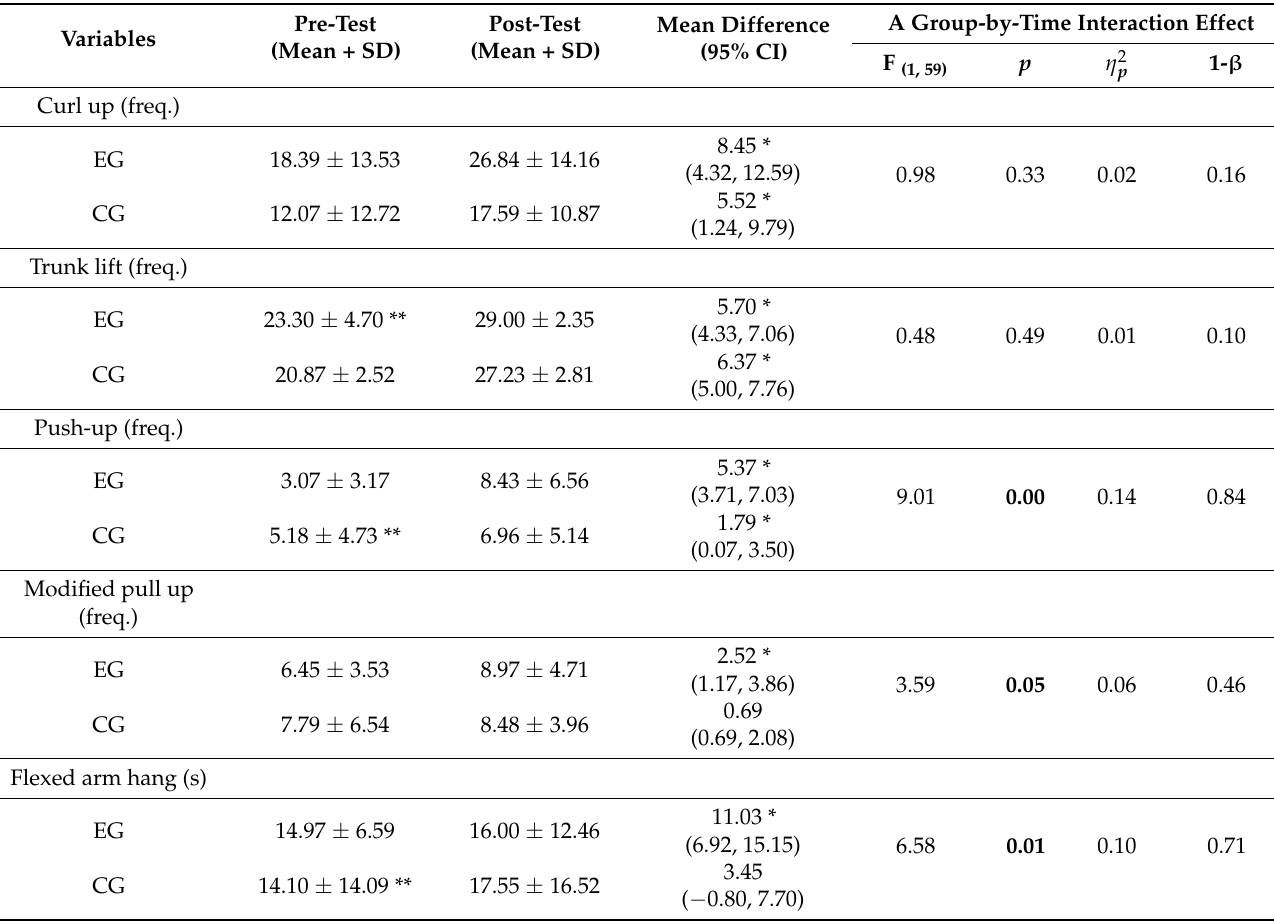
Table 5. Differences between EG ( n = 37) and CG ( n = 35) in HRF measures from pre- to